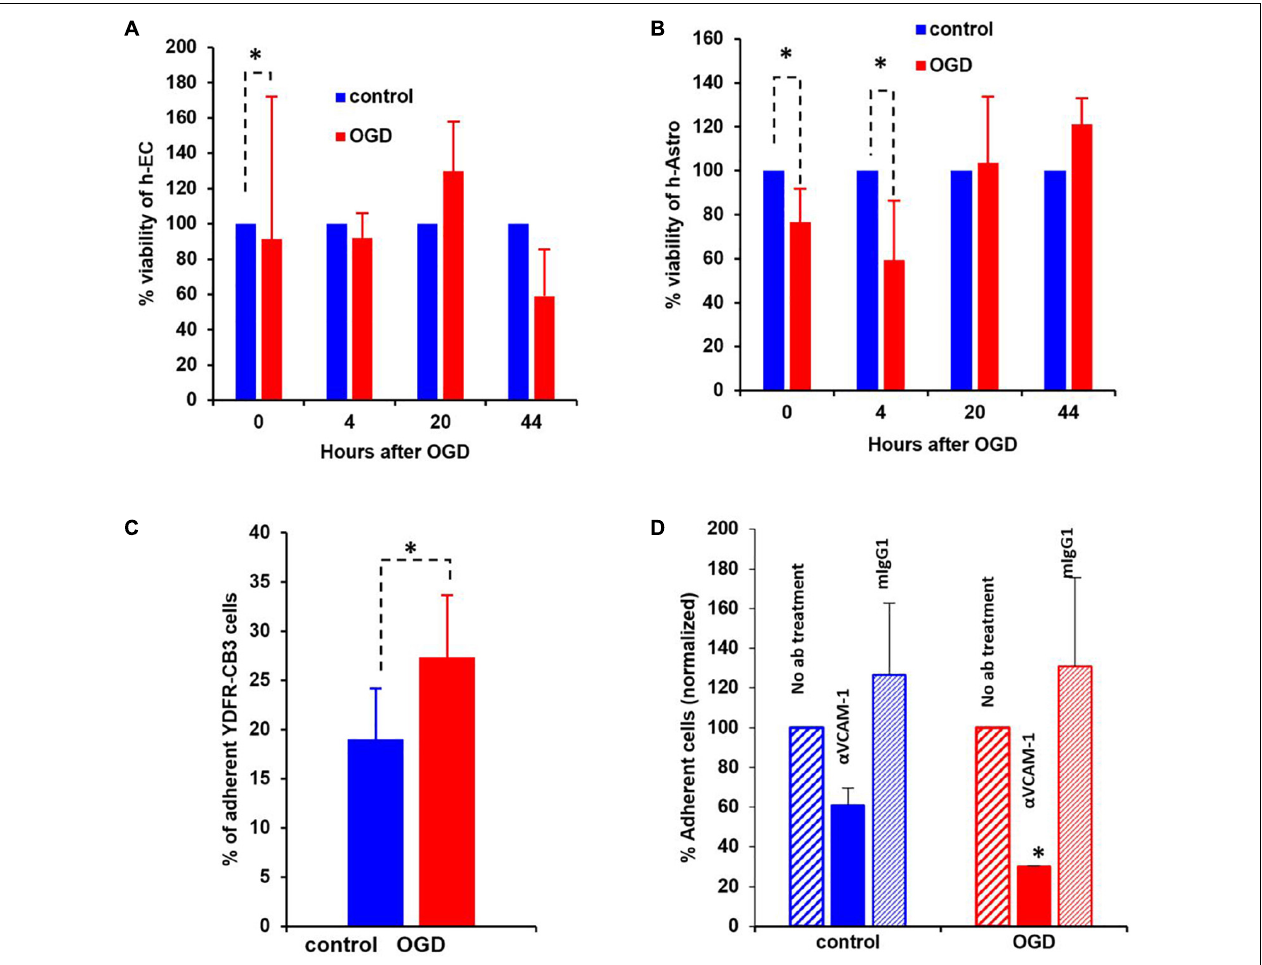
FIGURE 8 | Oxygen-glucose deprivation (OGD) affects viability of human-endothelial cells (h-EC), astrocytes (h-Astro) and adhesion of metastatic melanoma cells. (A,B) Percentage viability of h-EC (A) and h-Astro (B) subjected to OGD for 4 h followed by a 4, 20, and 44 h reperfusion phase. Cell viability as measured by XTT assay. The bars represent the average % viability of OGD exposed cells, normalized to control cells subjected to normal oxygen and glucose levels, mean ± SD, ∗ p < 0.05. The different time points indicate the hours in reperfusion after OGD/control conditions. (C) h-EC were subjected to OGD for 4 h followed by a 20 h reperfusion phase. m-Cherry expressing macro- and micro-metastatic melanoma cells were seeded on top of the h-EC monolayer and incubated for 30 min, to allow adhesion to occur. The fluorescence signal of labeled cells was measured before and after removal of non-adherent cells. The bars represent the % adherent cells in the wells. The graph represents an average of three independent experiments + SD. ∗ P < 0.05. (D) m-Cherry expressing metastatic melanoma cells were seeded on top of the OGD or control h-EC monolayers and incubated for 30 min with 5 µ g/mL VCAM-1 blocking Ab, an isotype control (mIgG1), or without IgG. The fluorescence signal of labeled cells was measured before and after removal of non-adherent cells. The bars represent % adherent melanoma cells seeded with anti-VCAM-1 blocking Ab or isotype control normalized to % adherent melanoma cells seeded without Ab. The graph represents an average of two independent experiments + SD. ∗ p <